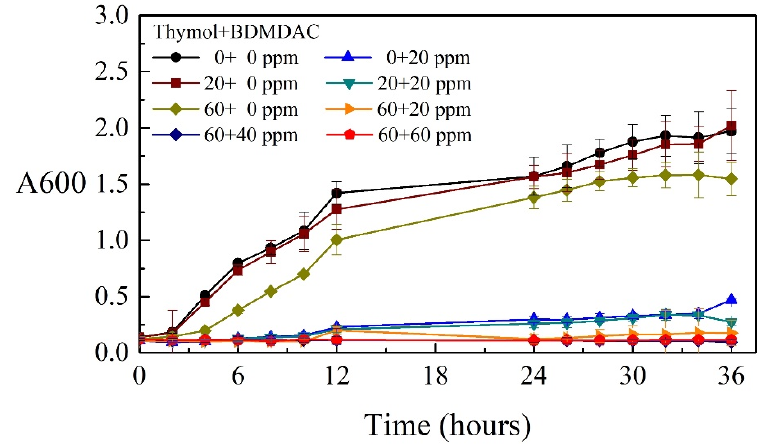
Figure 3. Microbial growth curves of varying concentrations of composite biocides applied to the Tamsui inocula.